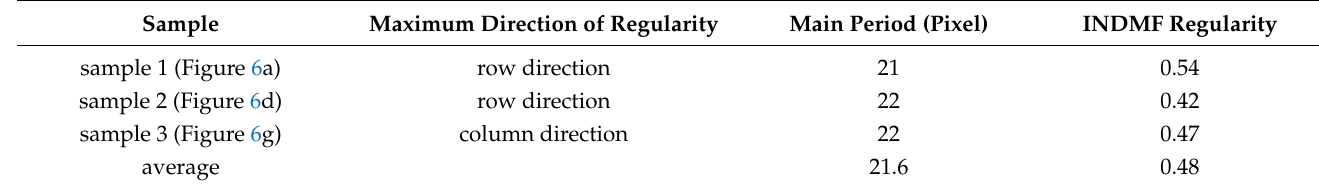
Table 7. Results of main period and INDMF regularity in the loess hill areas.